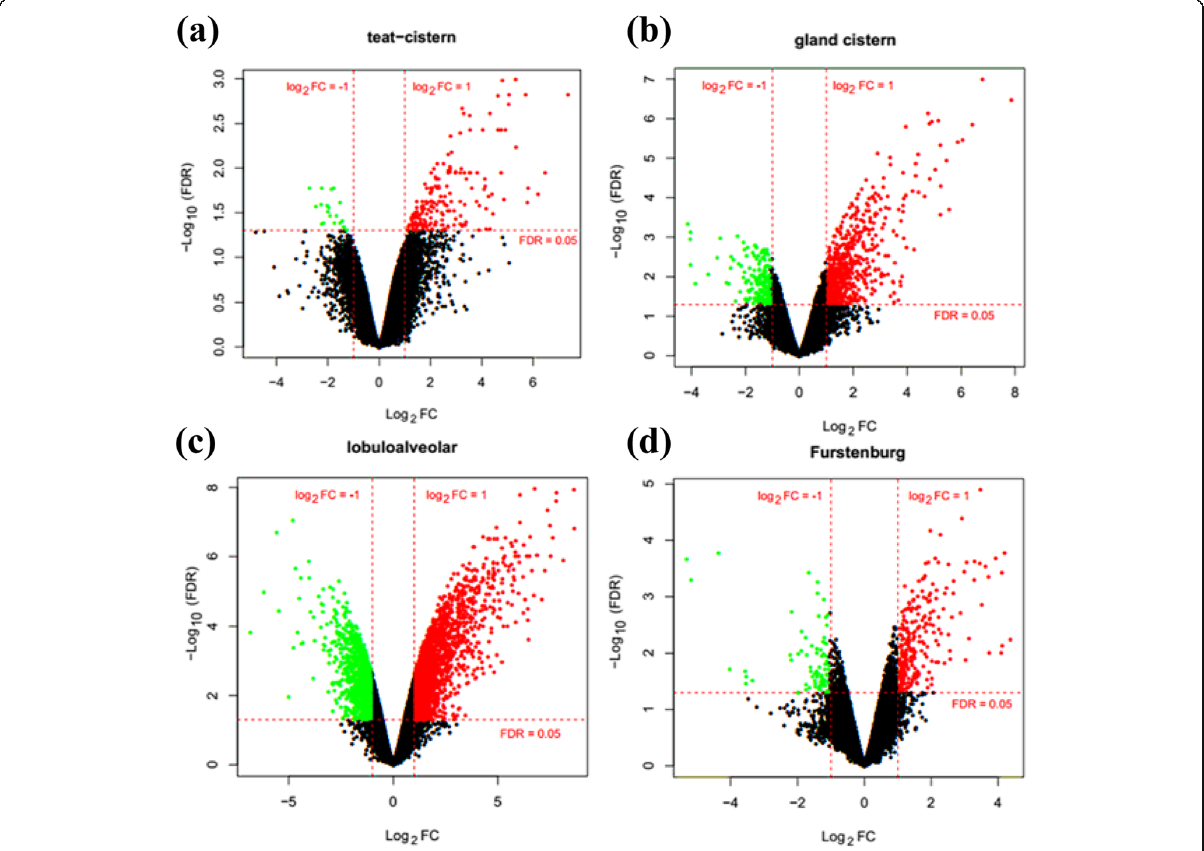
Fig. 1 Volcano plot of DEGs in teat cistern ( a ), gland cistern ( b ), lobuloalveolar ( c ), and Furstenberg ’ s rosette ( d ), regions. Red horizontal dot line means FDR = 0.05 cutoff line, two red vertical dot lines mean logFC = 1 and logFC = − 1 cutoff line. Gene dots that were distributed above the FDR = 0.05 red line and out of |logFC| = 1 were the DEGs we identified